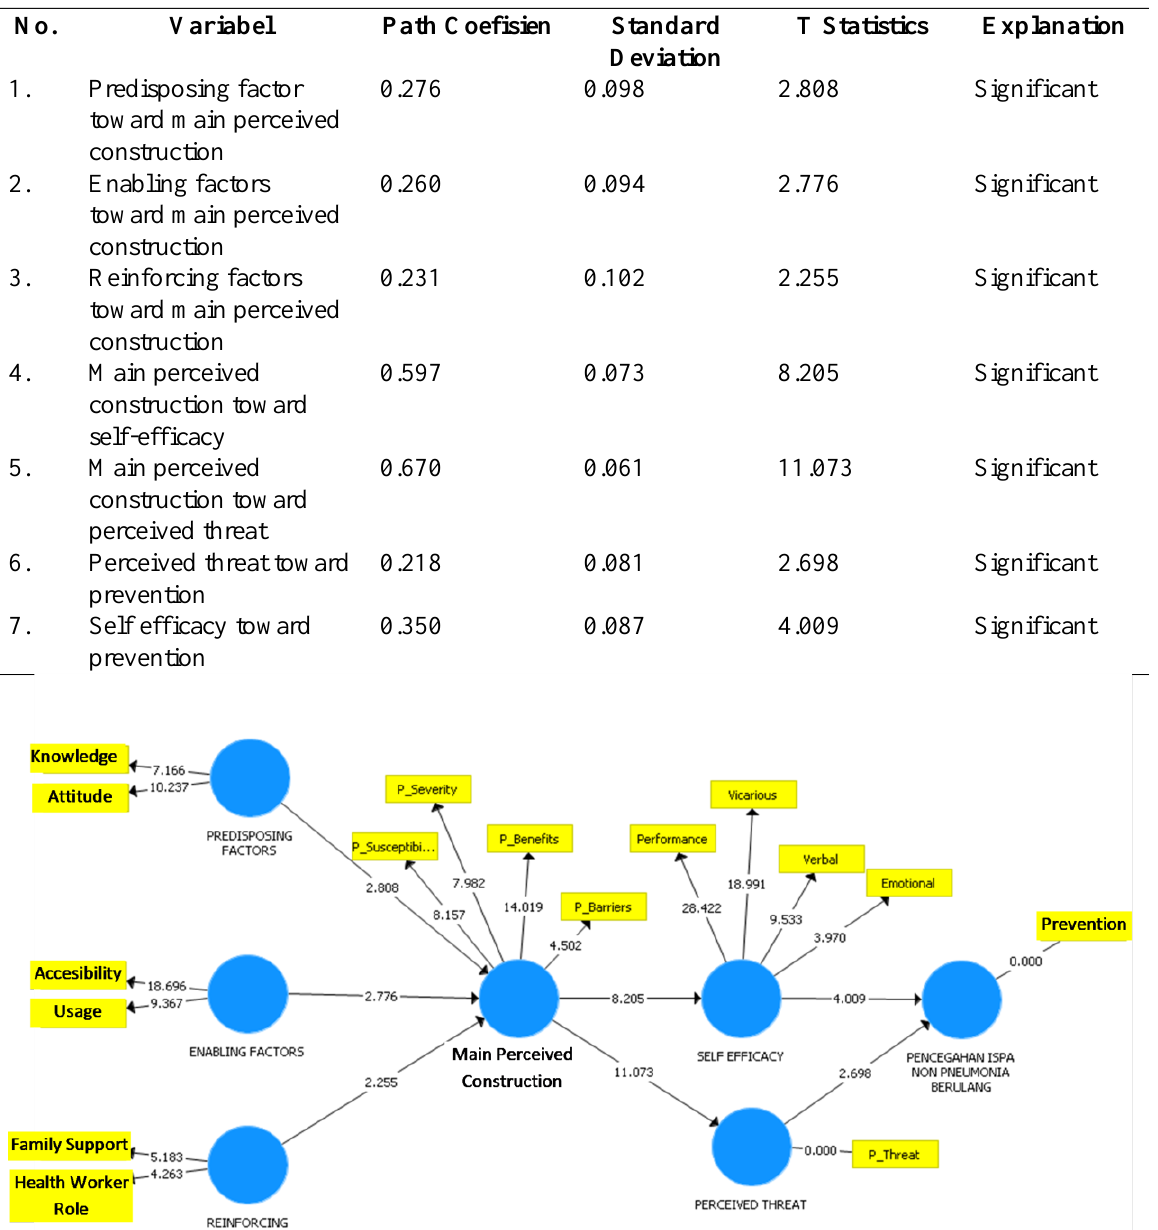
Figure 1. Analysis test results development of model on mothers self-efficacy in preventing recurrence of non-pneumonia acute respiratory infection among toddler in